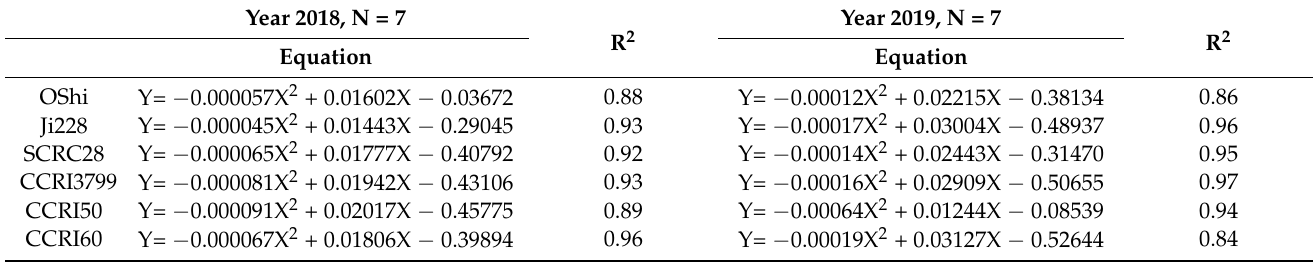
Table 2. iPAR simulation equations for six cultivars in 2018 and 2019: Y = aX 2 + bX + c.